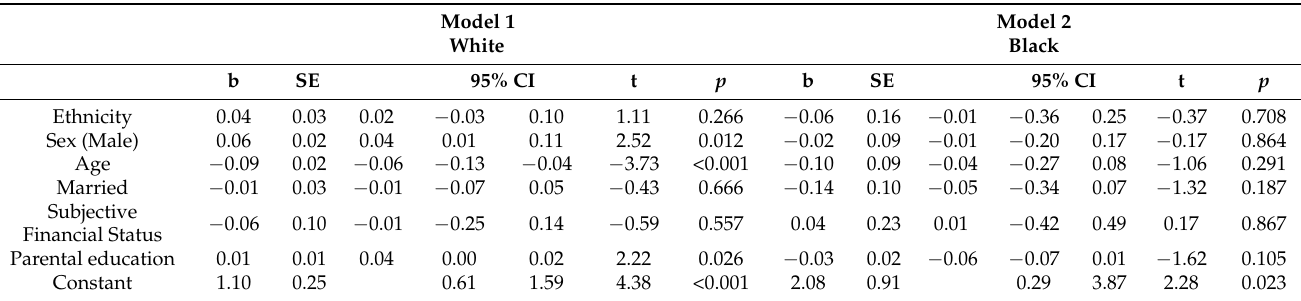
Table 2. Linear regressions by racial